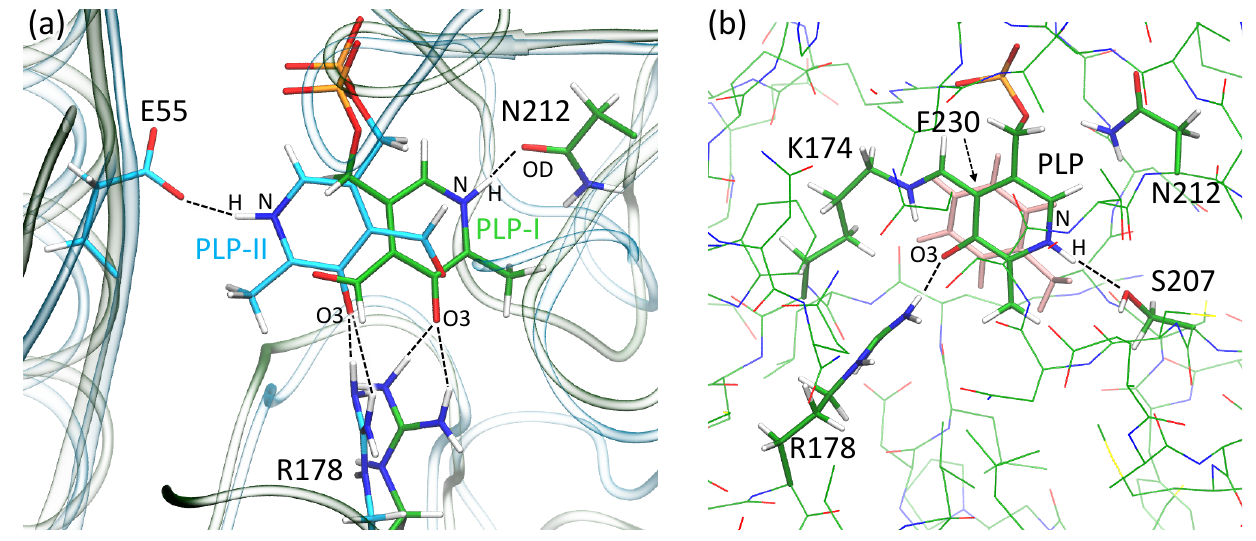
Figure 5. ( a ) Alignment of the binding sites of VP5454 with two different orientations of PLP, PLP-I and PLP-II. The protein backbone is shown with transparent ribbons, green for VP5454 with PLP-I and cyan for VP5454 with PLP-II. ( b ) The VP5454 N174K variant with the Schiff base between the side chain of K174 and PLP; the side chain of F230 that forms π– stacking interactions with the pyridine ring of PLP is shown in pink. Color code: carbon — green (cyan for the model with PLP-II), oxygen — red, nitrogen — blue, phosphorus — orange, hydrogen — white. Hydrogen bonds are shown with black dashed lines.